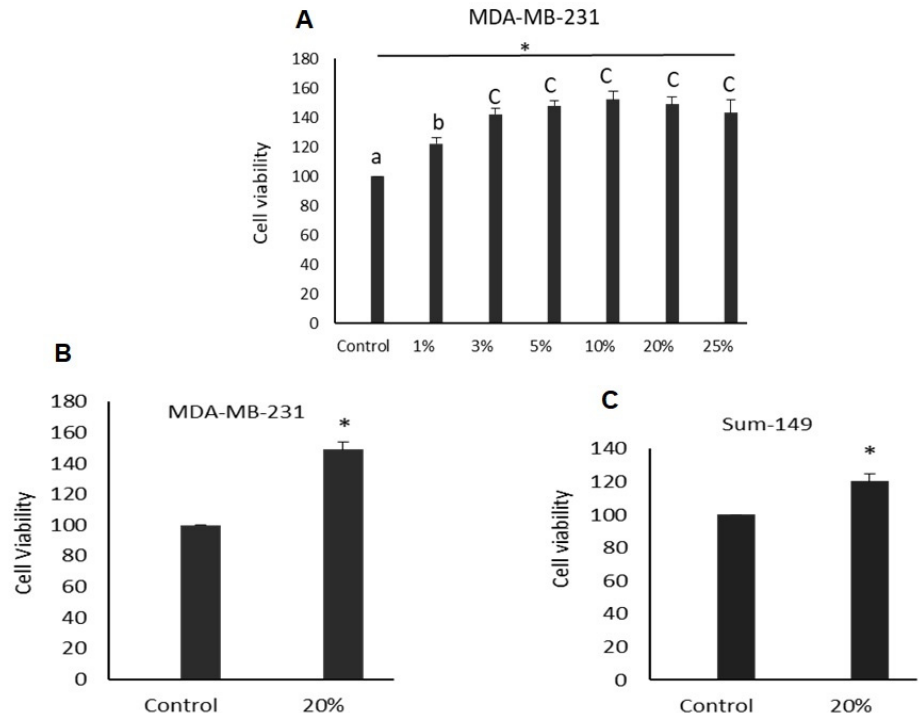
Figure 2. MTT assay. Bars represent cell viability for MDA-MB-231 and Sum-149 breast cancer cell lines cultured in WF of IBC ( n = 7) and non-IBC ( n = 12) patients for 48 h assessed by the MTT experiment. ( A ) MDA-MB-231 cells were stimulated for 48 h with various concentrations of WF (1%, 3%, 5%, 10%, 20%, and 25%). * indicates significant difference ( p < 0.05) as evaluated by one-way ANOVA test. Means with the different letters for different concentrations are significantly different ( p < 0.05); otherwise, they are not significantly different. ( B , C ) MDA-MB-231 and Sum-149 cell via- bility after being stimulated with 20% WF. The results are based on three independent experiments. Results are shown as mean ± SEM compared to control cell viability; * indicates significant p < 0.05 as evaluated by Student’s t -test.